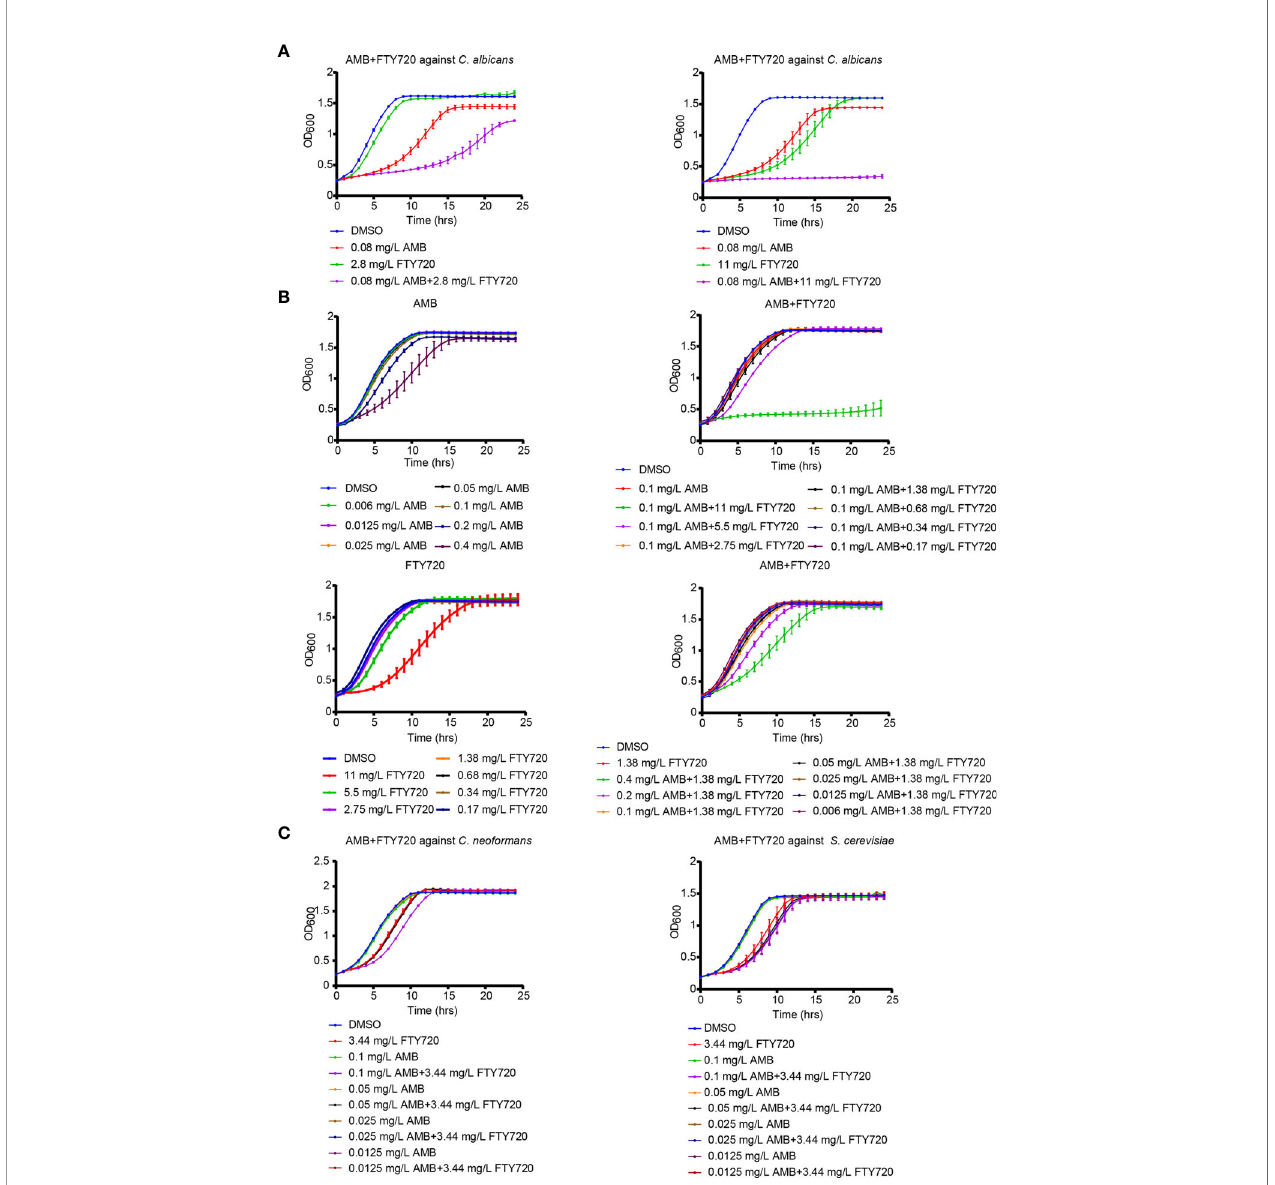
FIGURE 1 | Inhibitory effect of FTY720 and AMB on multiple fungal species. (A, B) Growth curve analysis of C. albicans in the presence of AMB and FTY720 at different concentration. The OD